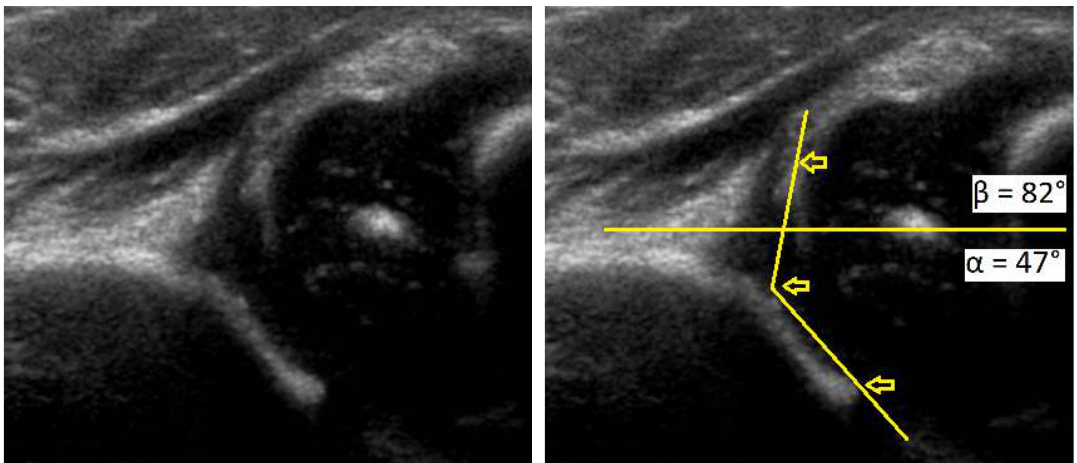
Figure 1. Development dysplasia of the hip (DDH)-ultrasound. In Graf’s classification type D (Decentring hip): Bony roof is severely deficient, bony rim is rounded to flattened, cartilage roof is displaced, α angle is 43–49 ° and β angle >77 °.